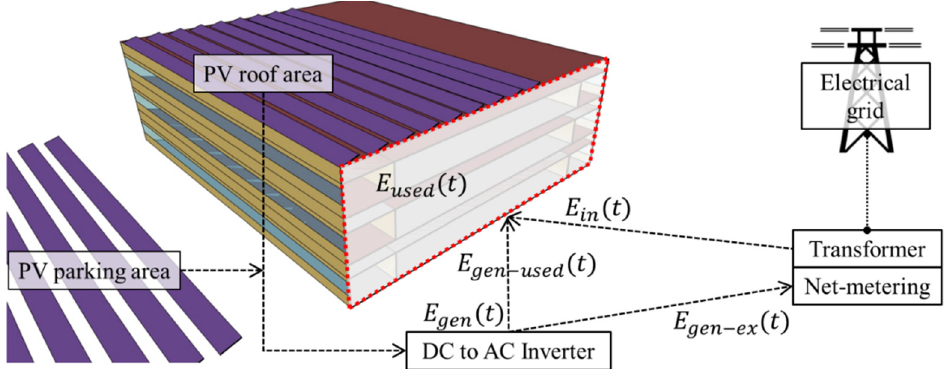
Figure 7. A simulation model with an on-site photovoltaics (PV) system with net-metering to enable net-zero carbon buildings (NZCBs) [10].